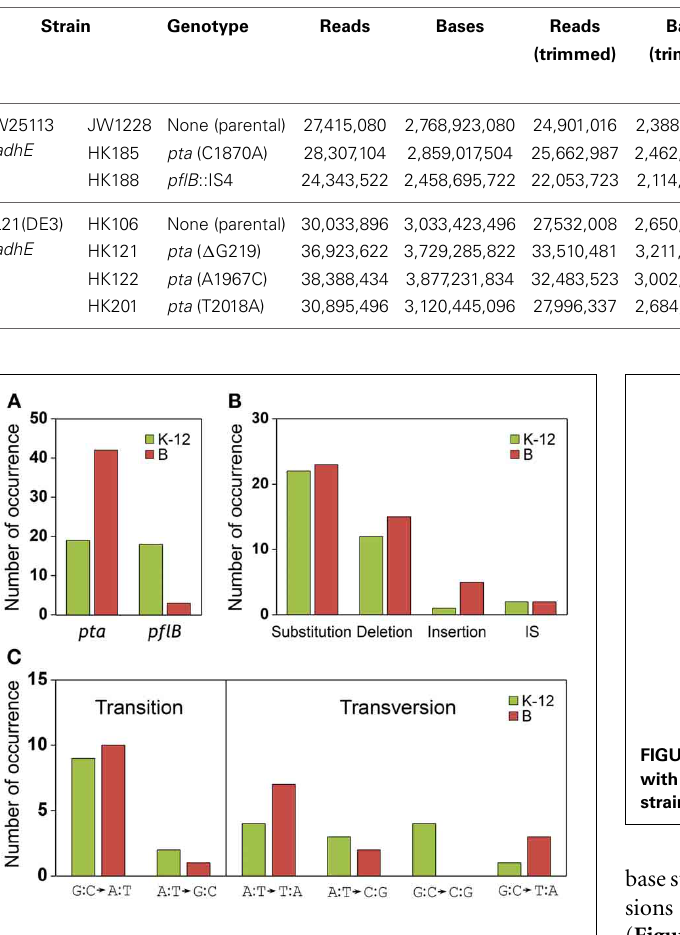
periods observed in the (cid:2) adhE parental cells and they completed